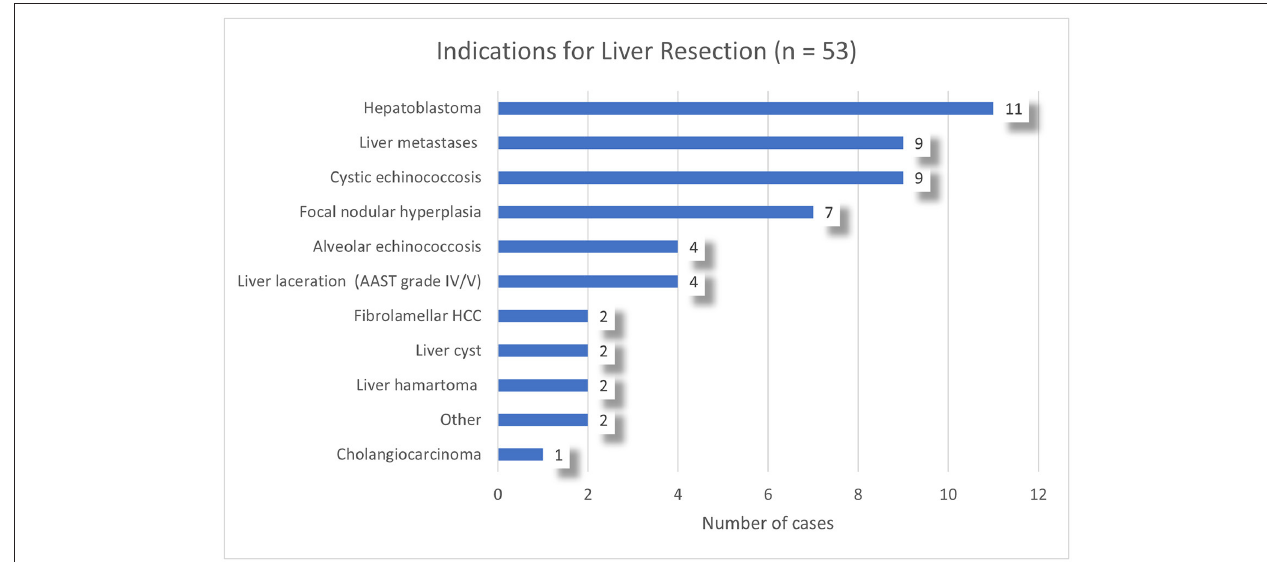
FIGURE 1 | Indications for liver resections in the study population.